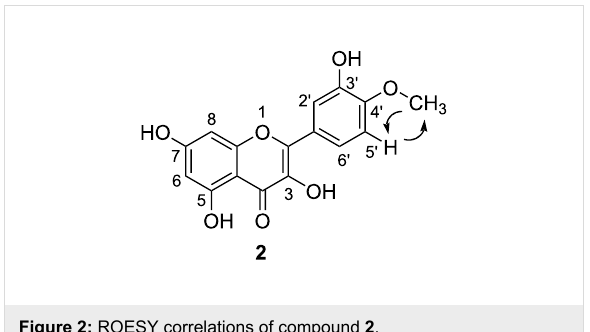
Figure 2: ROESY correlations of compound 2